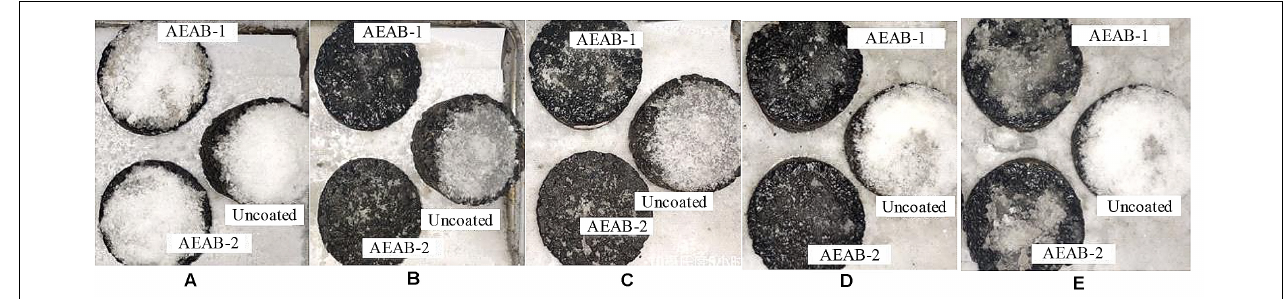
FIGURE 5 | Comparisons of ice-melting test at different temperature: (A) Initial state of each group. (B) − 5 ◦ C. (C) − 10 ◦ C. (D) − 15 ◦ C. (E) − 25 ◦ C.